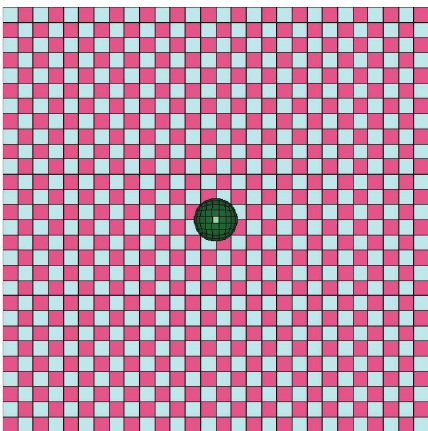
Figure 2: Mosaic model (laminate with